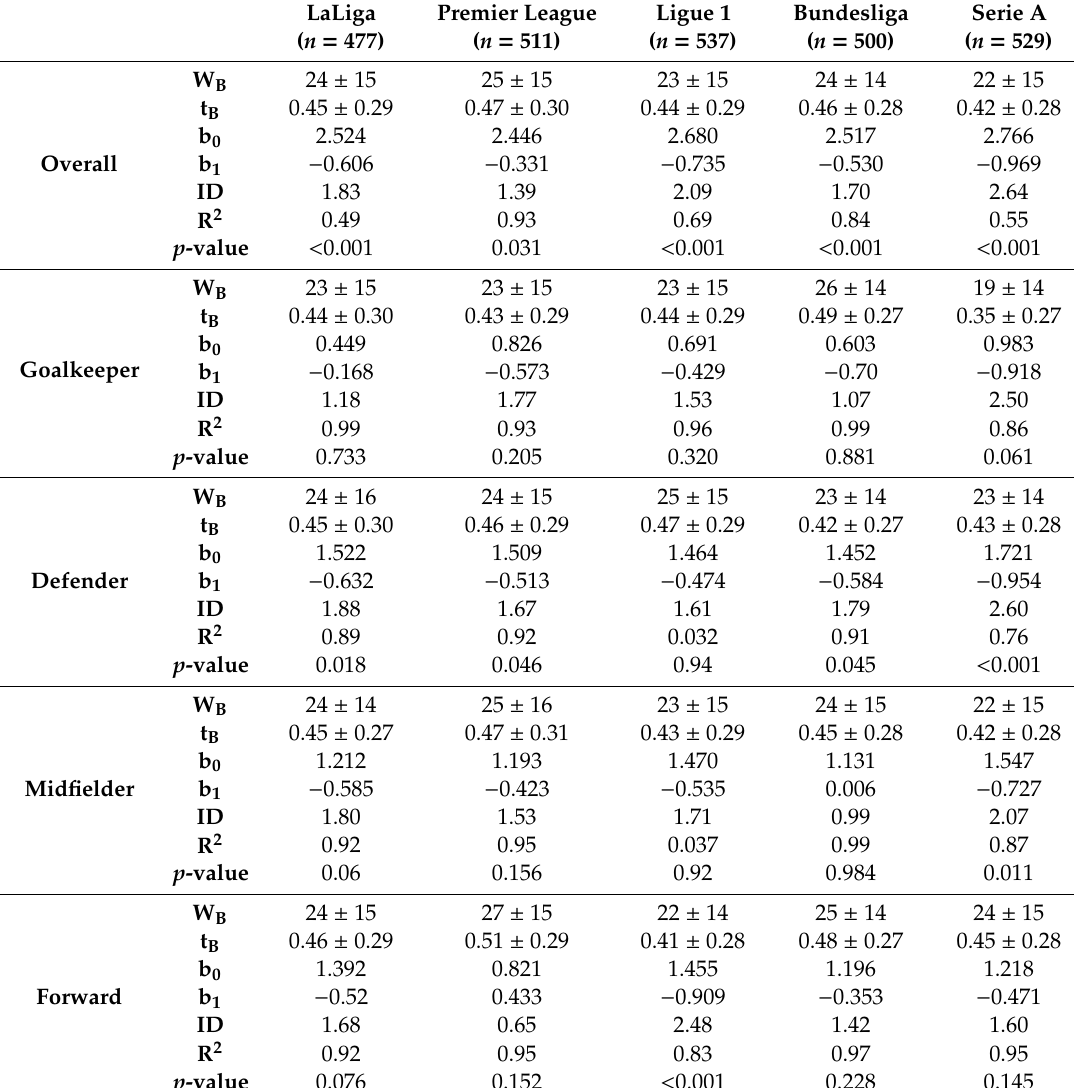
Table 3. Poisson regression analysis of relative age e ff ect (RAE) by frequency for all players and the di ff erent field